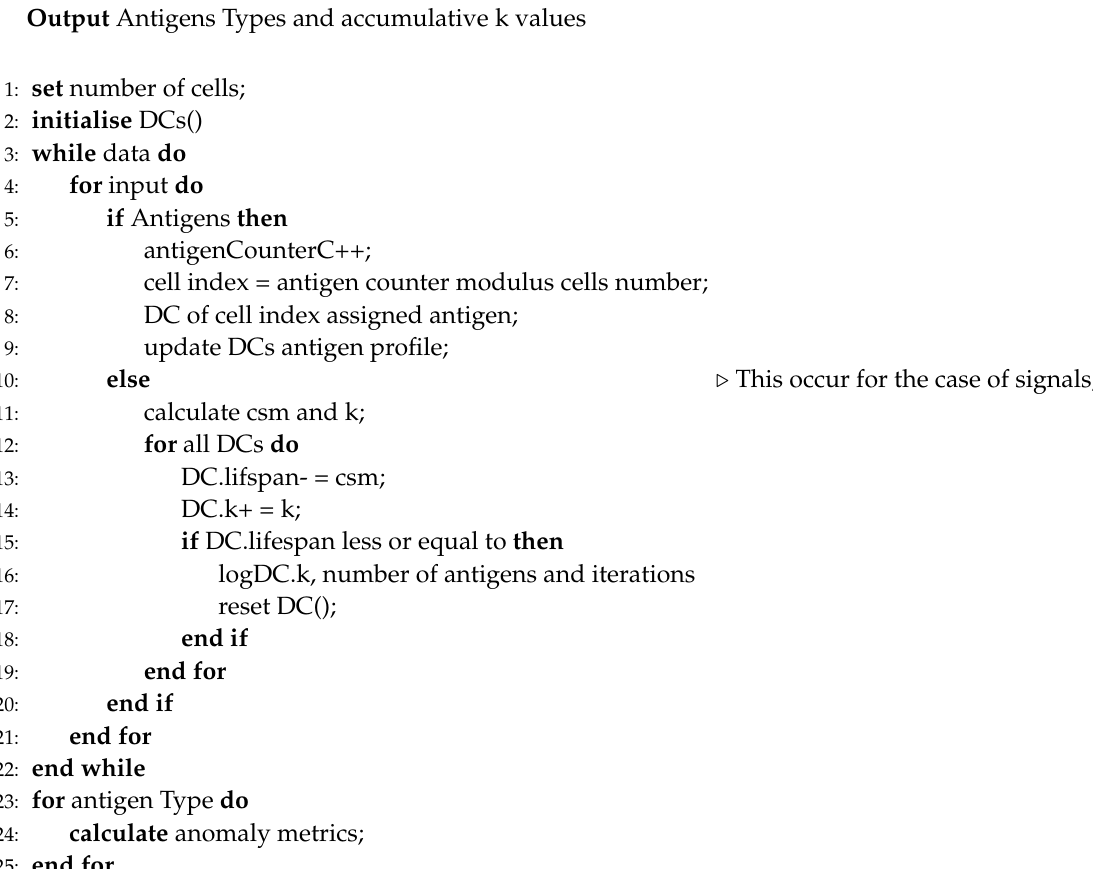
Algorithm 2 Determisnistic DCA for Intrusion